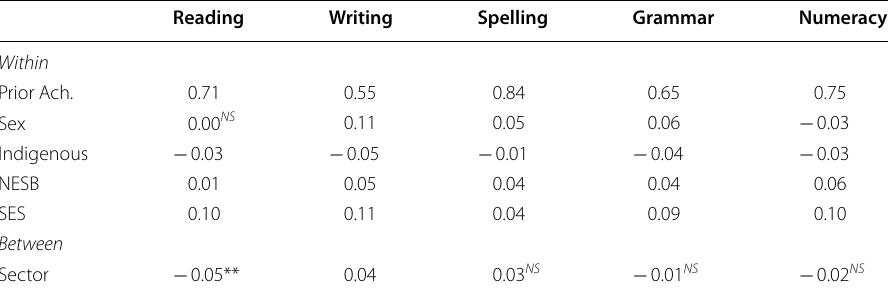
Table 2 Grade five standardised regression coefficients of control variables Reading Writing Spelling Grammar Numeracy Within Prior